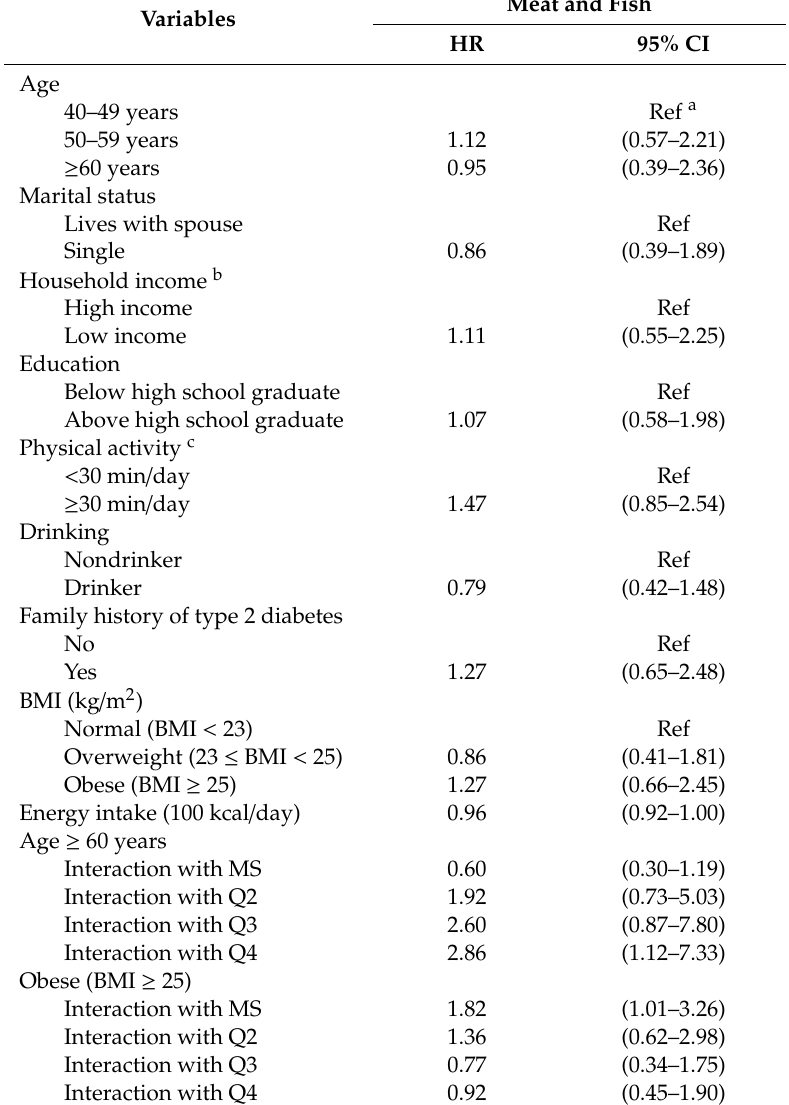
Table 5. Hazard ratios (HRs) and 95% confidence intervals (CIs) for type 2 diabetes from multivariable stratified Cox regression with interaction terms of metabolic syndrome and meat and fish dietary patterns in female